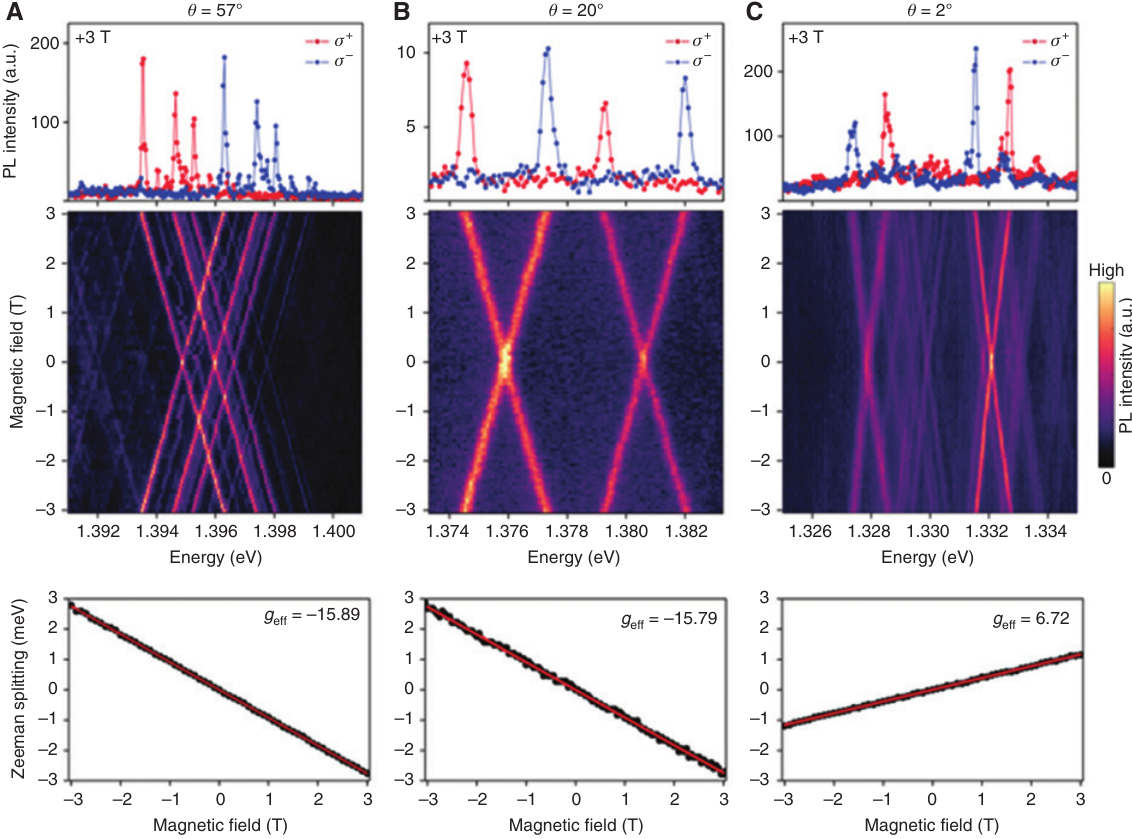
Figure 6: Zeeman effect of excitons trapped in moiré superlattice. (A–C) Magnetic field-dependent PL from interlayer excitons in the MoSe /WSe heterobilayer with twist angles of 57 ° (A), 20 ° (B), and 2 ° (C). 2 2 Top, helicity-resolved PL spectra at 3 T. The excitation is linearly polarized, and the σ + and σ − components of the PL are shown in red and blue, respectively. Middle, plot of total PL intensity as a function of magnetic field, showing a linear Zeeman shift of the σ + and σ − polarized PL. Bottom, Zeeman splitting of the polarization-resolved PL [ Δ = E σ + –E σ − , where E σ + (E σ − ) is the peak energy of σ + ( σ − ) polarized peak] as a function of the applied magnetic field. The effective g -factors for the three samples (−15.89 ± 0.02, −15.79 ± 0.05, and 6.72 ± 0.02 for A–C, respectively) are extracted from a linear fit of Δ versus magnetic field (B; solid red line). Reproduced with permission from Ref. [73], Nature Publishing